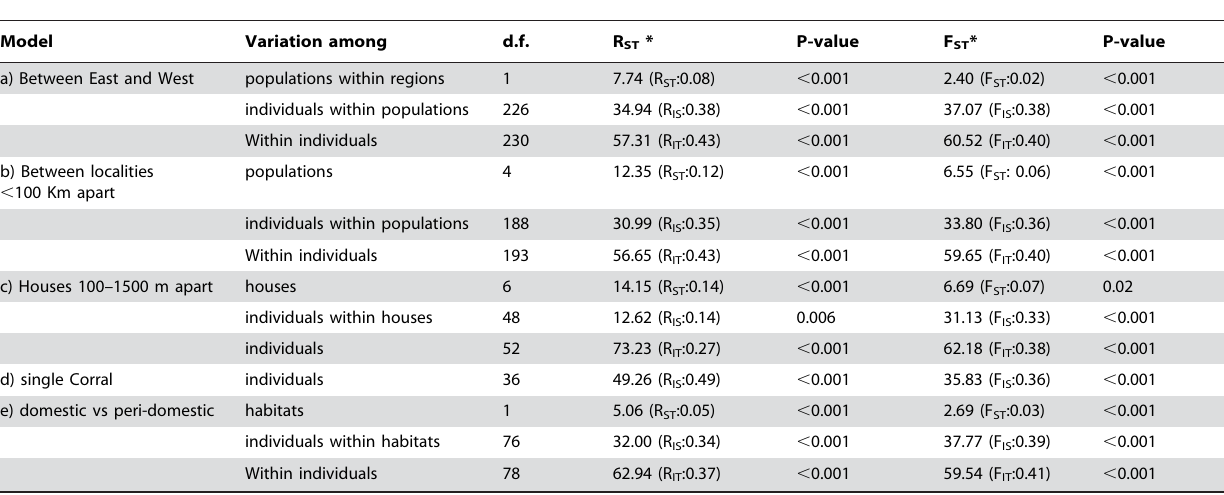
For population information see Table 1. Significance levels based on 1000 permutations, *=percent of variation.